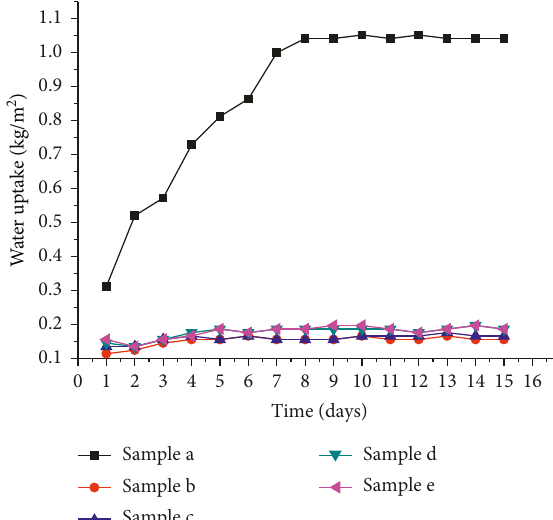
Figure 7: Effect of length reduction on water absorption of the hydrophobic sample.